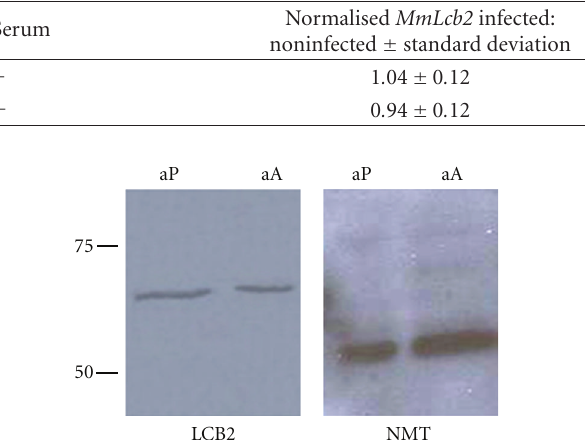
Figure 5: Lysates of 5 × 10 6 axenic procyclic promastigotes (aP) and amastigotes (aA) probed with the cross reacting Lmj LCB2 and Lmj NMT antibodies in a Western blot. Molecular weight markers in kDa shown on left of